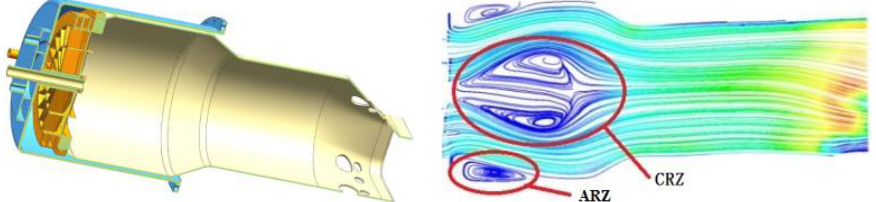
Figure 1. Schematic diagram and flow feature of the combustor. Table 1. The combustor inlet conditions for the design point.